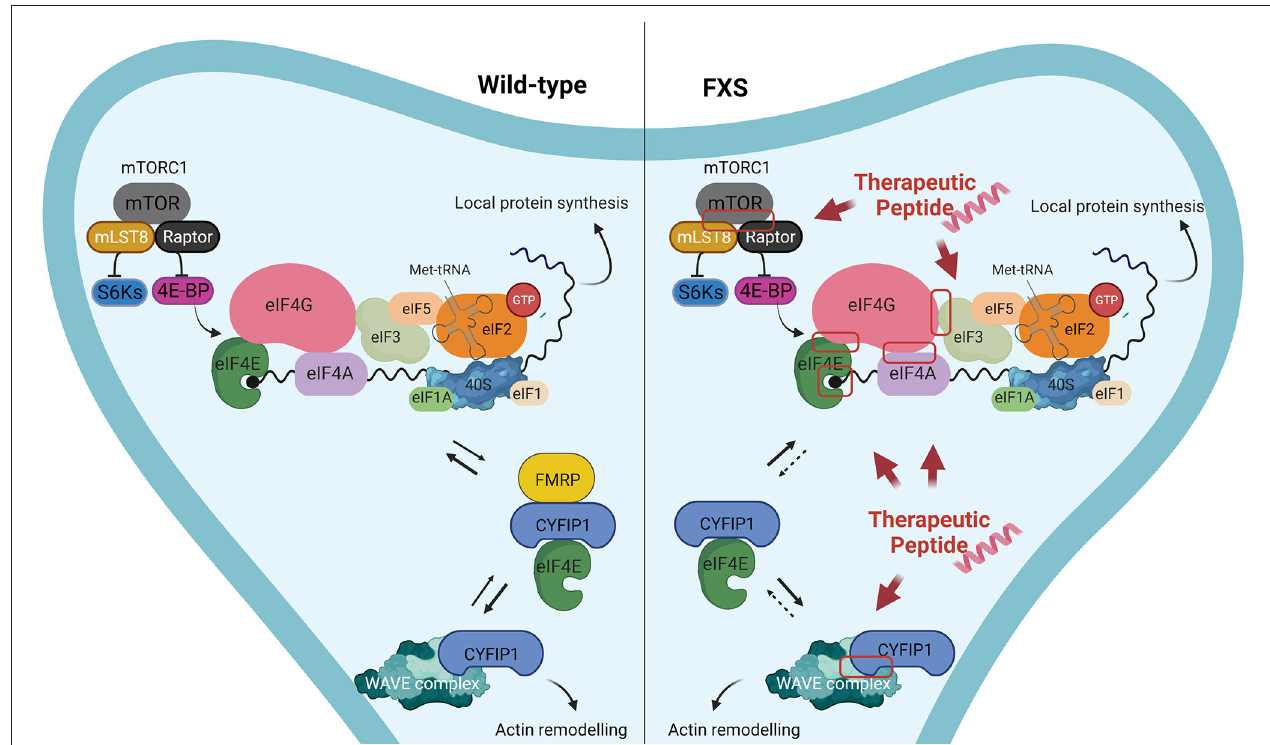
FIGURE 1 | Proposed examples of protein-protein interactions that could be targeted by peptides/peptidomimetics in Fragile X Syndrome. Left panel: In wild-type neurons FMRP plays a key role in down-regulating the translation of FMRP targets, by forming a complex with CYFIP1 and the eukaryotic initiation factor 4E (eIF4E). Furthermore, CYFIP1 can bind and inhibit the WAVE regulatory complex, thereby regulating actin remodeling. Right panel: In FXS neurons the absence of FMRP leads to increased local protein synthesis in neurons, due to the lack of the formation CYFIP1-FMRP-eIF4E complex, that represses the translation initiation. Consequently, a bigger amount of eIF4E is bound to eIF4G, while CYFIP1 interacts mostly with WRC-Rac1-GTP, resulting in higher levels of protein synthesis an altered actin remodeling at dendritic spines. Examples of macromolecular complexes that could be disrupted by peptides/peptidomimetics with the aim to restore the FMRP activity are highlighted by a red